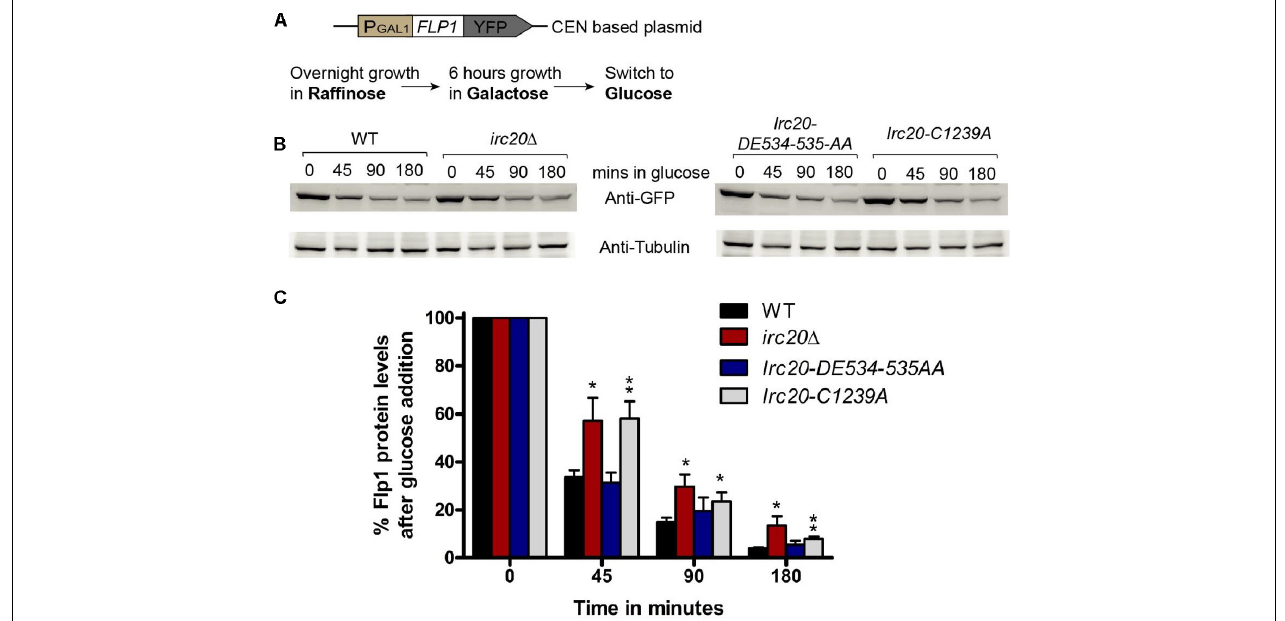
FIGURE 3 | Loss of Irc20 ubiquitin ligase activity increases the levels of Flp1. (A) WT, irc20 (cid:49) , Irc20-DE534-535AA and Irc20-C1239A [cir 0 ] mutants transformed with a centromeric plasmid (pRS416) expressing YFP-tagged Flp1 under GAL1 -promoter were grown for 6 h in media containing 2% galactose to induce expression of Flp1 and then transferred to media containing 2% glucose to monitor the degradation of Flp1. (B) Whole cell extracts of cells grown for 45, 90, and 180 min in media containing glucose were analyzed for Flp1 levels by western blotting using anti-GFP antibody. (C) Band intensities were normalized to Tubulin band signals, and quantified as a percentage of signals before glucose addition. Values are the average of at least four replicate experiments, and are presented as mean ± SEM. Statistical significance was calculated by two-tailed Student t -test for unpaired samples. One asterisk shows p -value < 0.05 and two asterisks show p -value < 0.01, as compared to